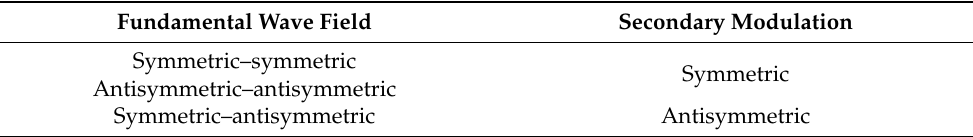
Table 2. Possible secondary wave fields due to Lamb wave mode mutual